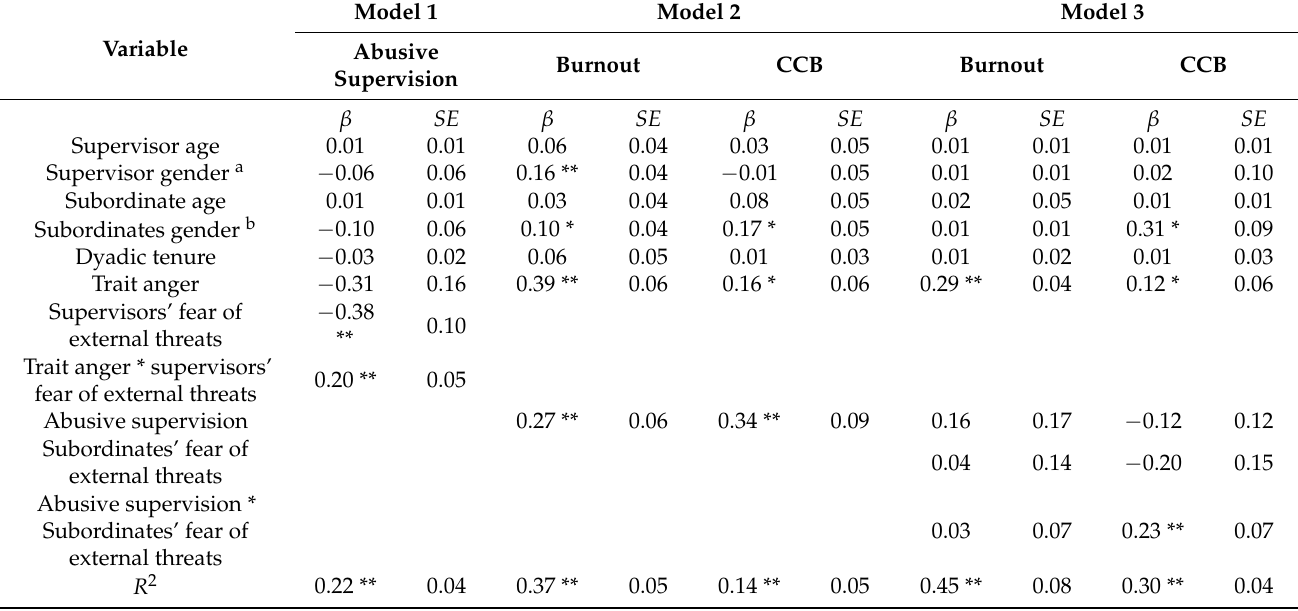
Figure 2. The moderating role of supervisors’ fear of external threats in the relationship between trait anger and abusive supervision.